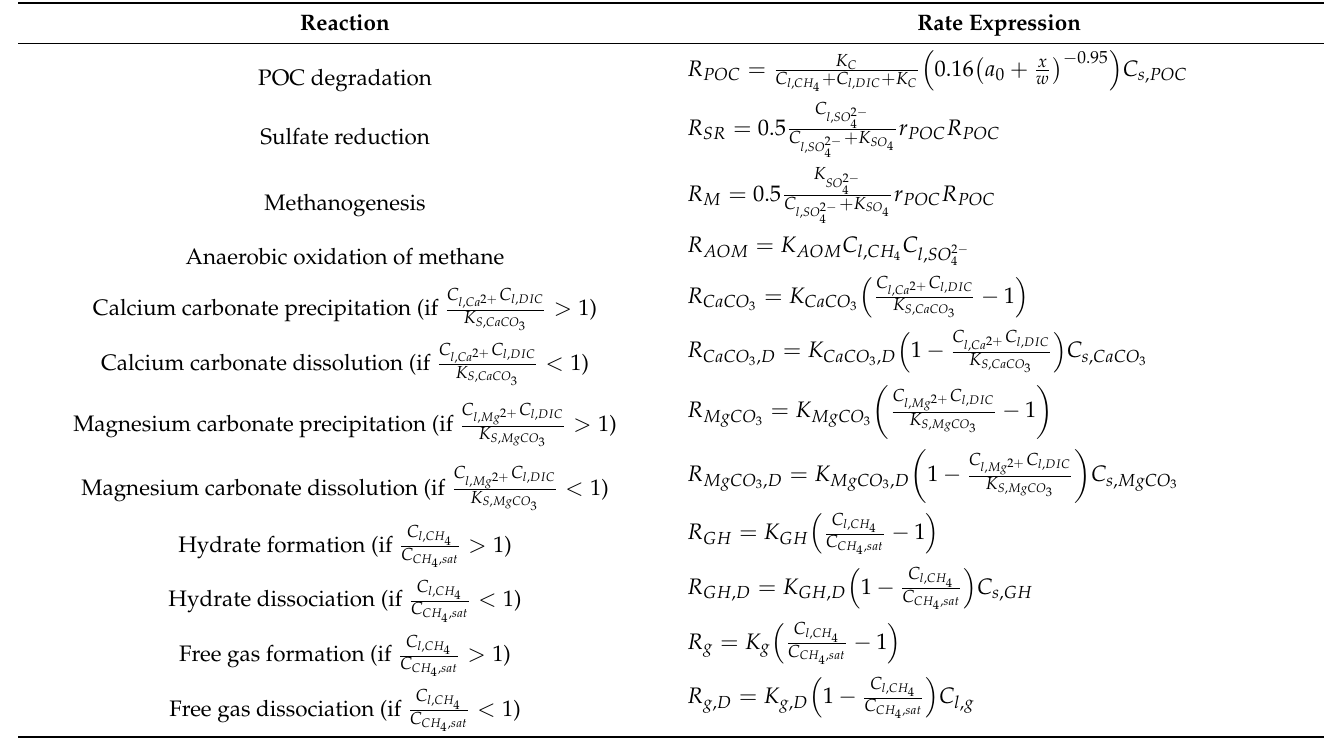
Table A2. The rate laws used in the